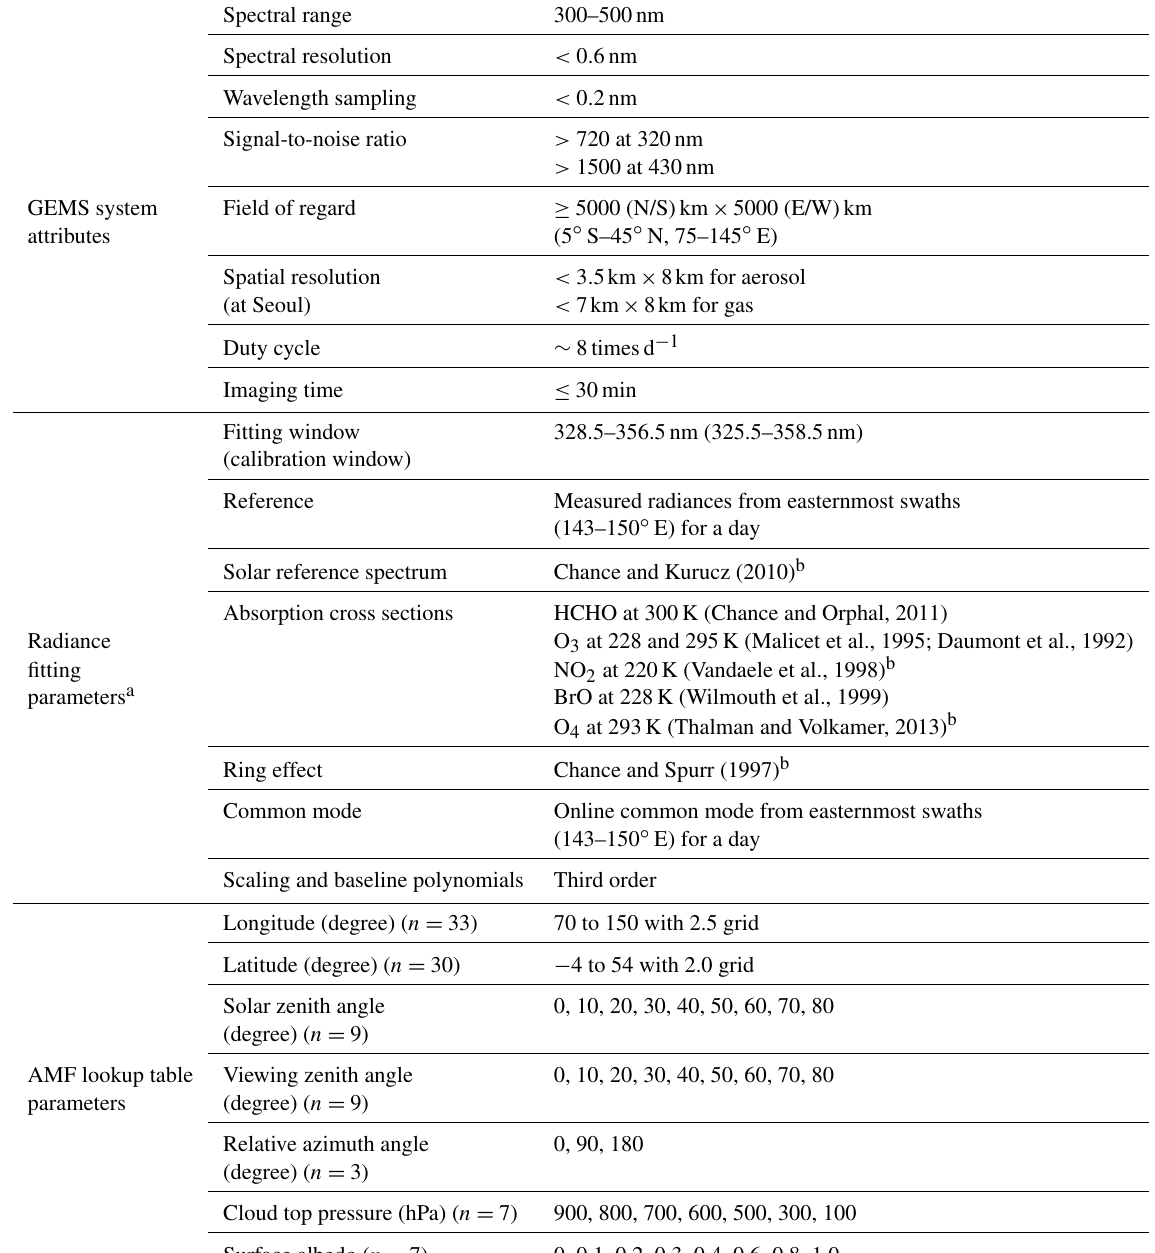
Table 1. Summary of GEMS system attributes, parameters for radiance fitting, and parameters for the air mass factor (AMF) lookup table.